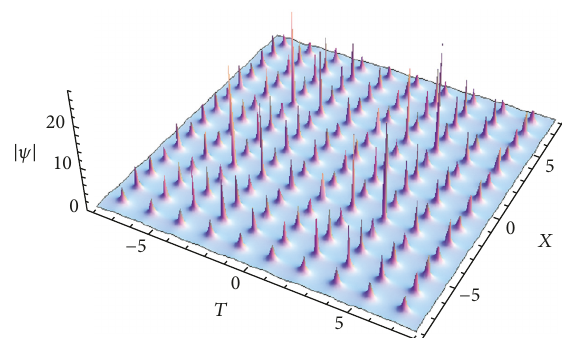
Figure 13: Spatial structure of the module of solution (81) with 𝑘 = 2 .